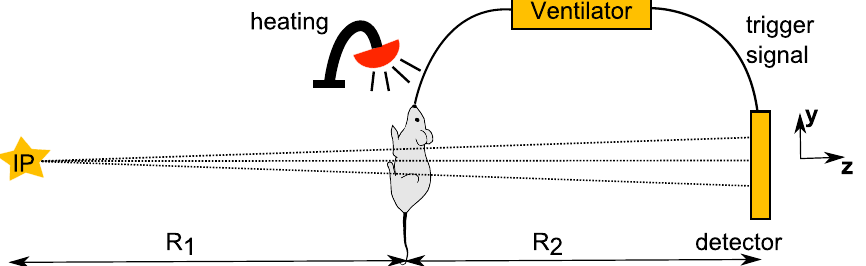
Figure 5. Set-up for in vivo mouse imaging at the Munich Compact Light Source. The mouse is held head-high in a vertical position to enable either an anteroposterior (AP) projection (e.g. of the lungs) or a lateral (Lat) projection (e.g. through the trachea). The mouse can be intubated and ventilated, with the ventilator configured to send a trigger signal to the detector to minimize respiratory motion during an exposure of the lungs. The source-to-sample distance R 1 was 4 m and the propagation distance R 2 was chosen as 1